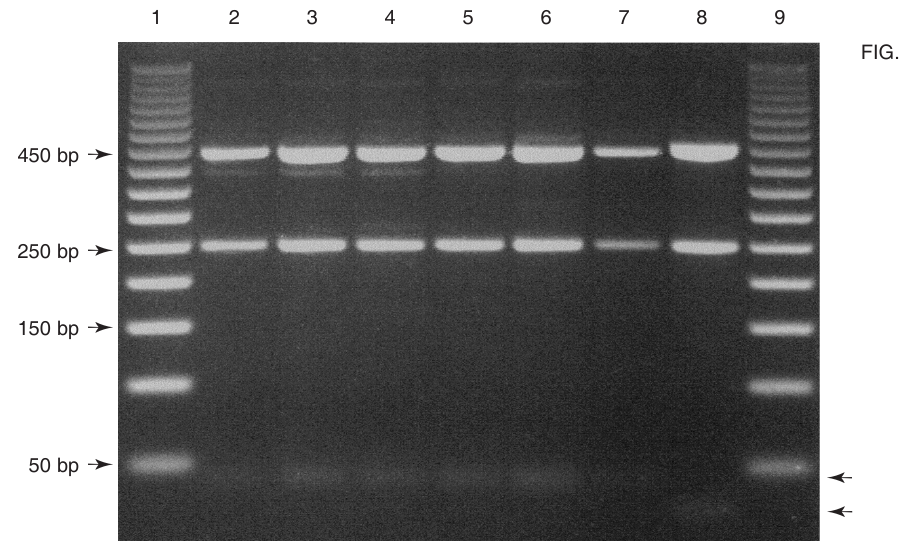
FIG. 1 Restriction digest profile for the samples obtained from ring-neck parakeets using the restriction enzyme Hae III. The digest products were loaded onto a 2.5 % agarose gel together with a 50 bp step ladder (Promega) [Lanes 1 and 9]. Samples P- BLM-1, P-BLM-2, P-BLM-3, P-BLM-4, P-BLM-5, P-BLM- 6 and P-GEO were loaded in lanes 2–8 respectively. Arrows on the right hand side indicate the discrepan- cy found of the ~50 bp band between the six samples obtained from Bloemfontein (upper arrow) in comparison to the sample obtained from George (lower